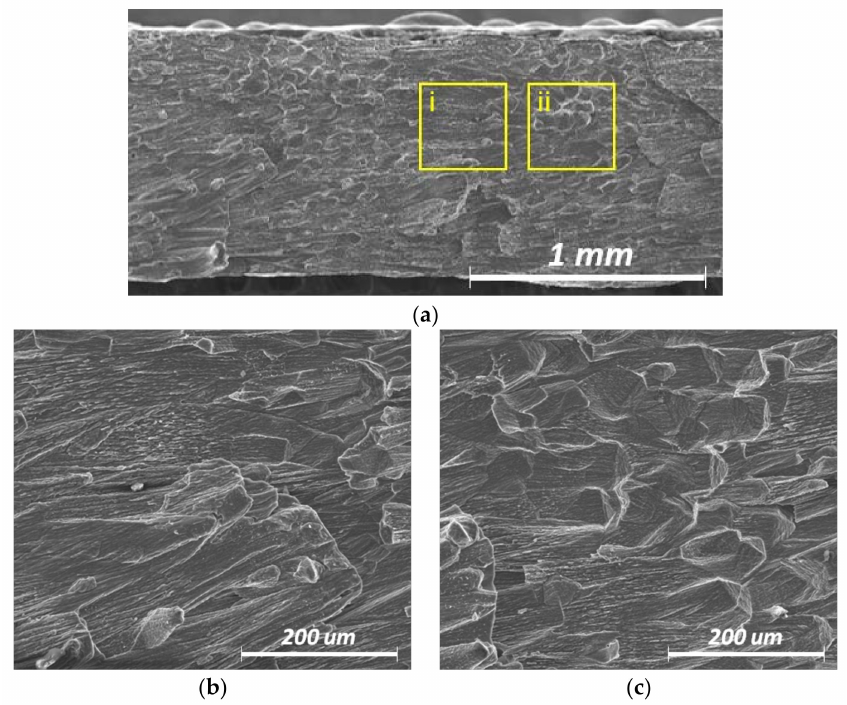
Figure 12. EBSD analysis with varying oscillation frequencies. Welding was performed with infinite-shaped beam pattern under 900 W laser power at 3.5 m/min welding speed. The oscillation width was fixed at 0.8 mm, while the frequency was varied at ( a ) 0 Hz; ( b ) 100 Hz; ( c ) 200 Hz and ( d ) 300